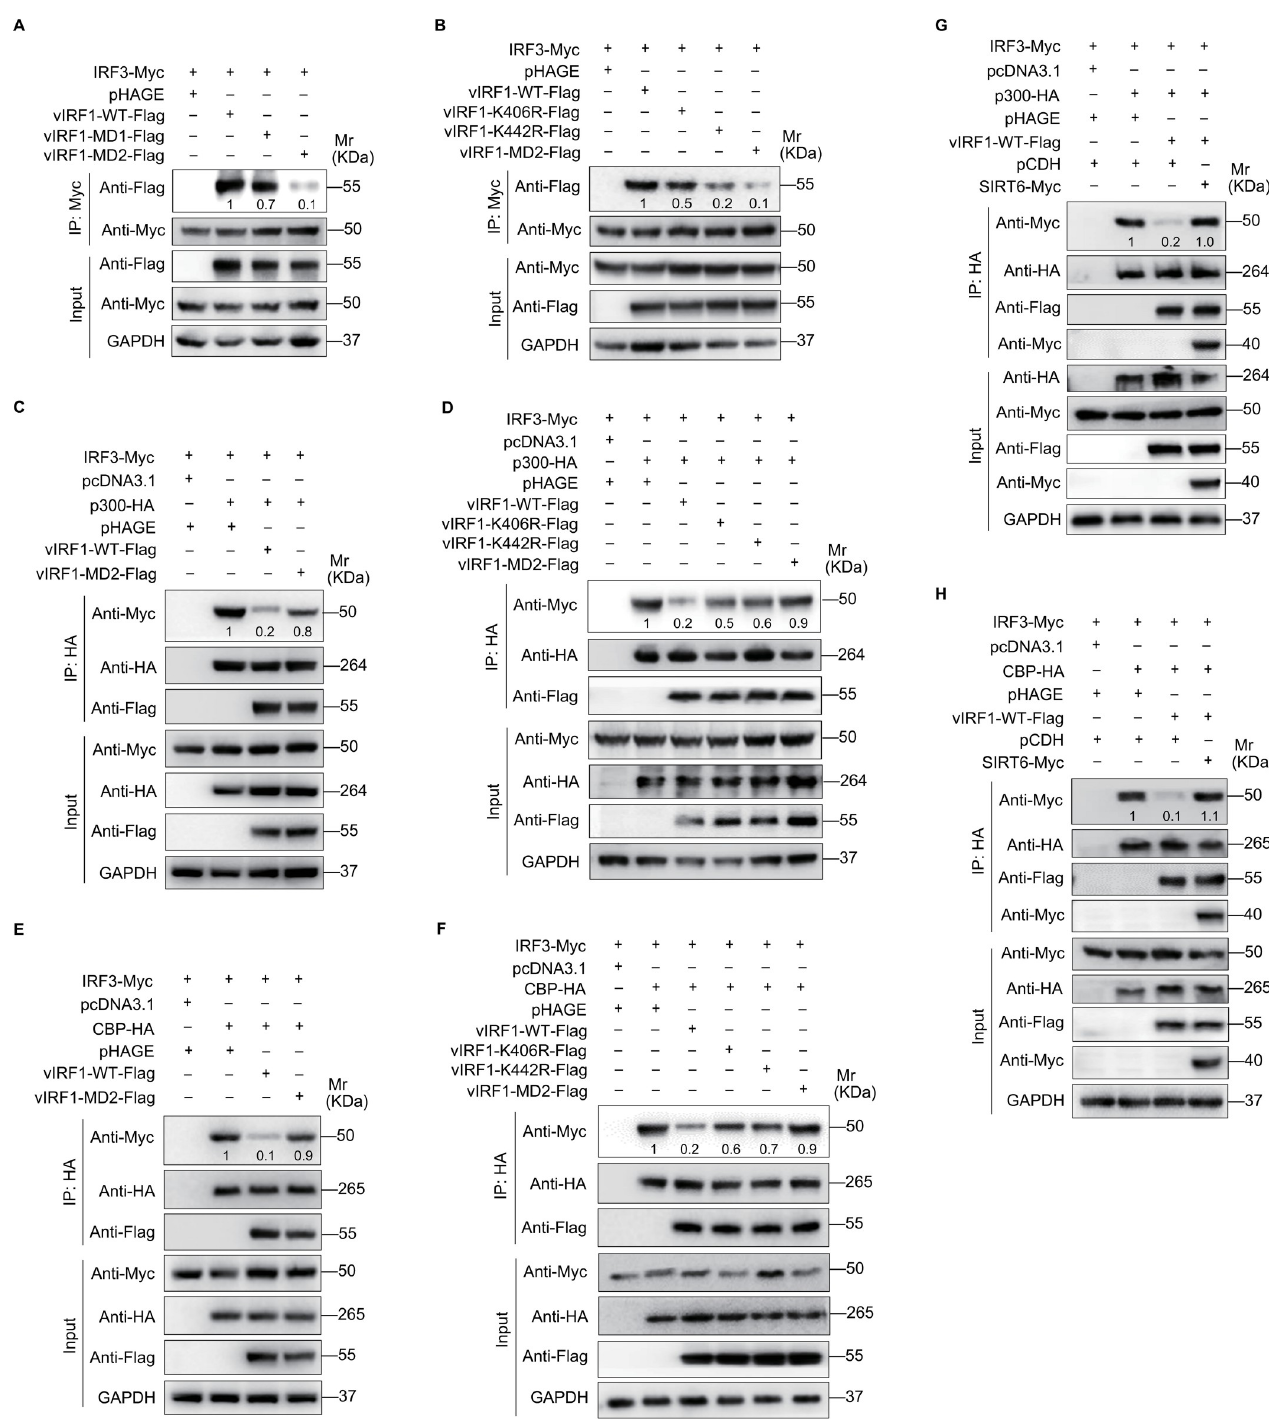
Fig 5. vIRF1 propionylation blocks the formation of IRF-3-CBP/p300 complexes. (A). HEK293T cells with IRF3 overexpression ( IRF3-Myc ) were transfected with the wild type vIRF1 ( vIRF1-WT-Flag ), DBD-mutated vIRF1 ( vIRF1-MD1-Flag ), IAD-mutated vIRF1 ( vIRF1-MD2-Flag ), or its control ( pHAGE ). Cells were subjected to the anti-Myc immunoprecipitation and analyzed by Western blot using anti-Flag antibody. The relative intensities of the bands were quantified and normalized to Myc-tagged IRF3. The values are labeled under the protein bands. The relative values of proteins in the vIRF1-WT-Flag group were set as “1” for comparison. (B). HEK293T cells with IRF3 overexpression ( IRF3-Myc ) were transfected with the wild type vIRF1 ( vIRF1-WT-Flag ), the mutant vIRF1 ( vIRF1-K406R-Flag , vIRF1-K442R-Flag , vIRF1-MD2-Flag ), or its control ( pHAGE ). Cells were subjected to the anti- Myc immunoprecipitation and analyzed by Western blot using anti-Flag antibody. The relative intensities of the bands were quantified as in ( A ). (C).